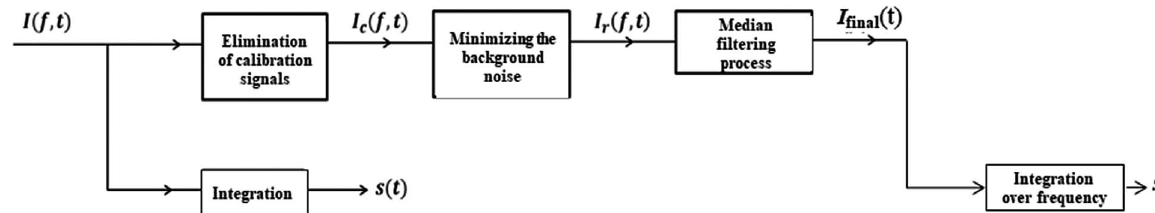
Fig. 3. Proposed denoising and interference mitigation